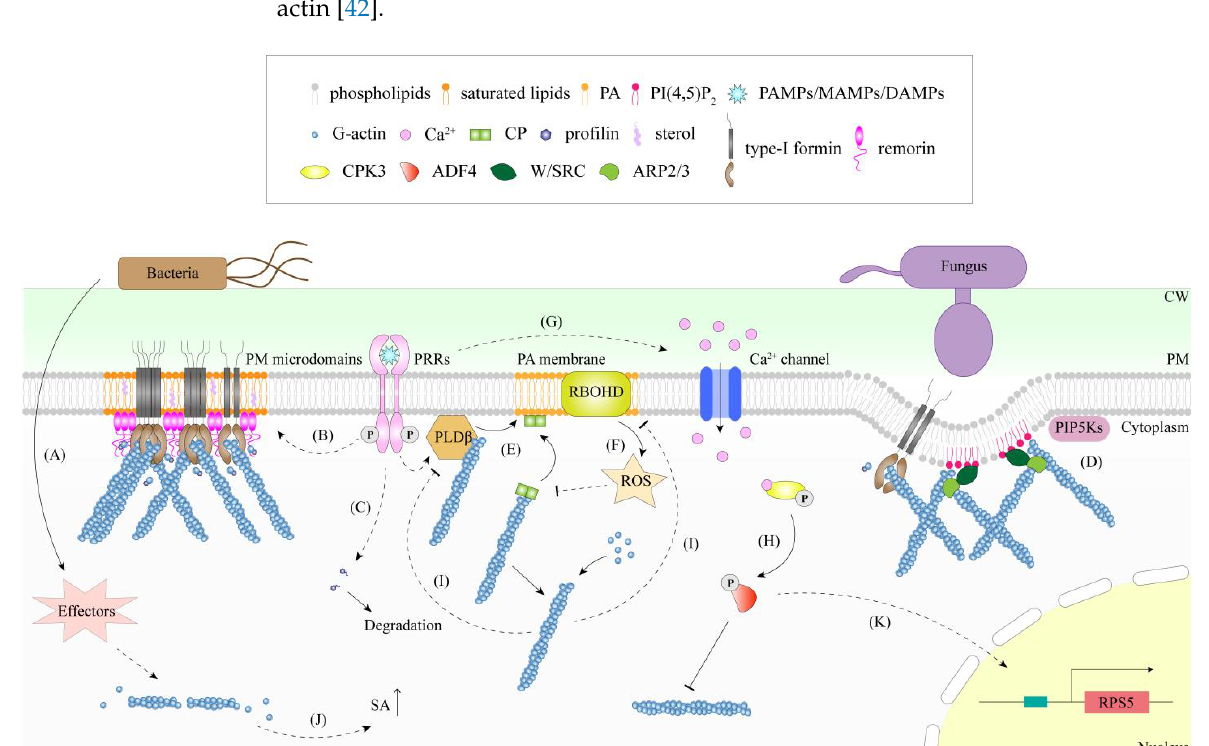
Figure 1. Regulation of actin filament dynamics in epidermal cells during plant immunity. ( A ) Sensing of bacteria induces actin filament remodeling, while bacteria produce effectors targeting